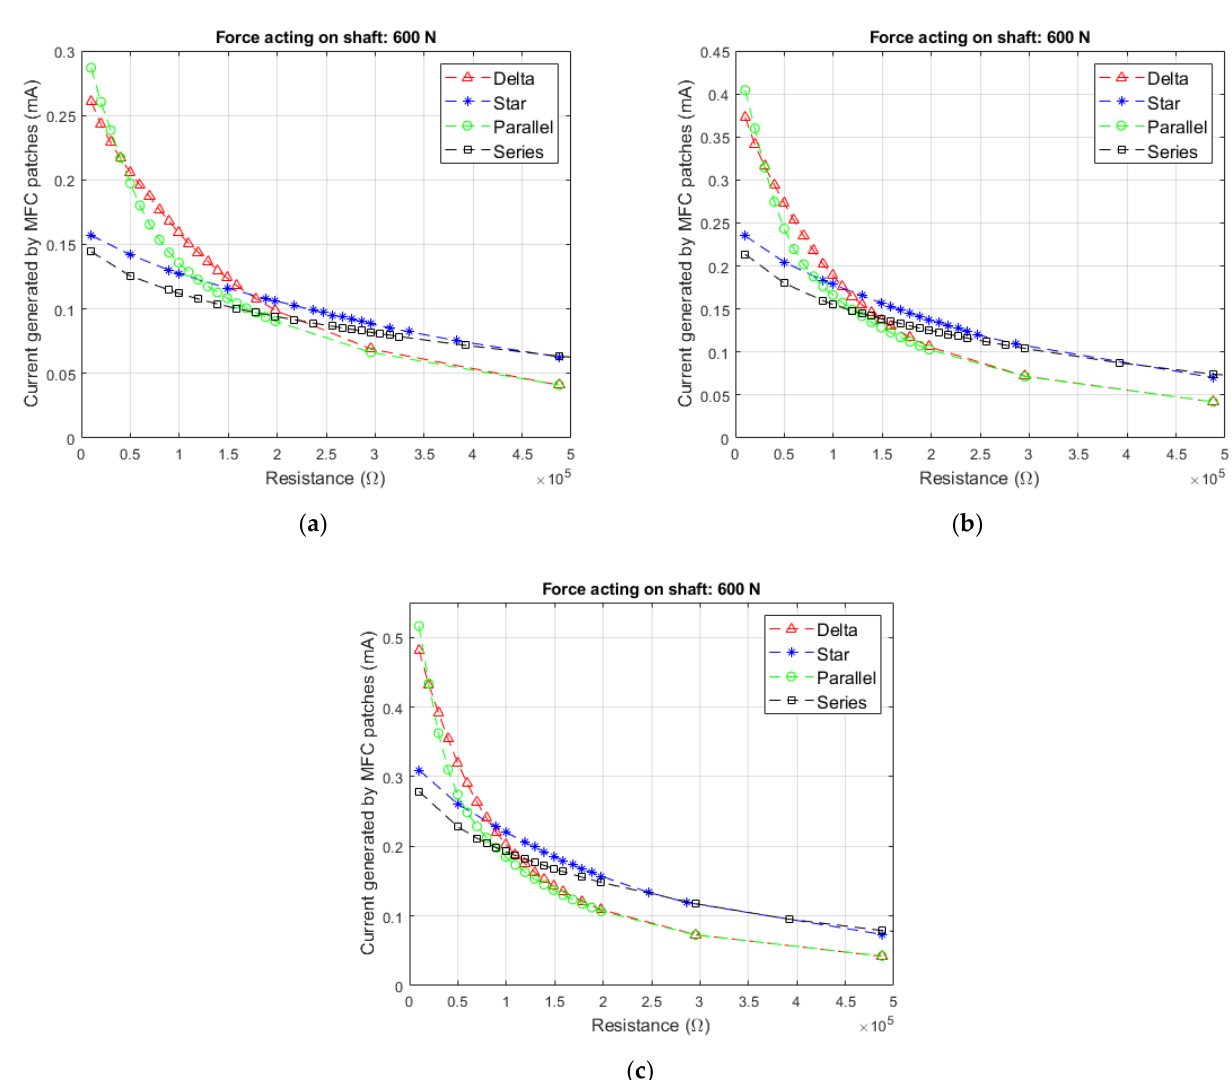
Figure 7. Electrical power generated for a force equal to 600 N: ( a ) rotational speed equal to 10 rps; ( b ) rotational speed equal to 15 rps; and ( c ) rotational speed equal to 20 rps.